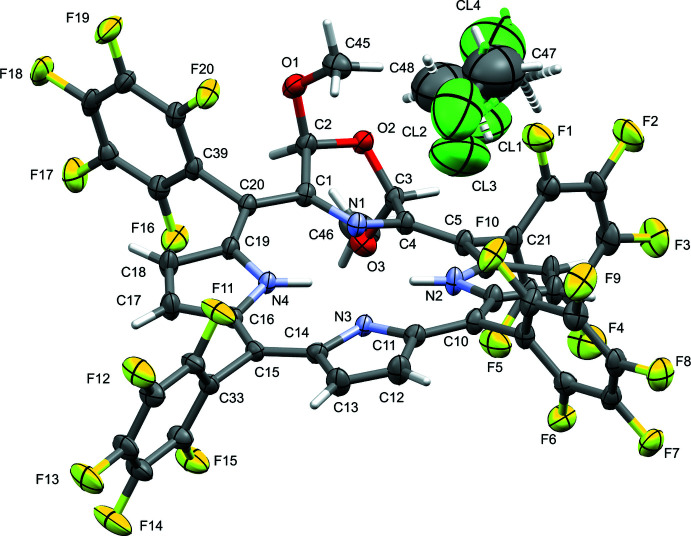
F⋯F inter­actions (turquoise dashed lines) creating a triangular motif. Symmetry-related moieties are truncated to their penta­fluoro­phenyl groups, and atoms not directly involved in an inter­action are shown in stick mode for clarity. Symmetry codes: (vii) −x + , y − , −z + ; (viii) −x + , −y + , −z + 1.